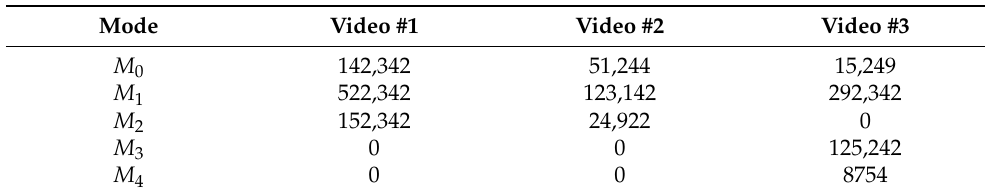
Table 5. Example of descriptor comparison. N 1 , N 2 , and N 3 are the number of times that each mode is used in Videos #1, #2, and #3.